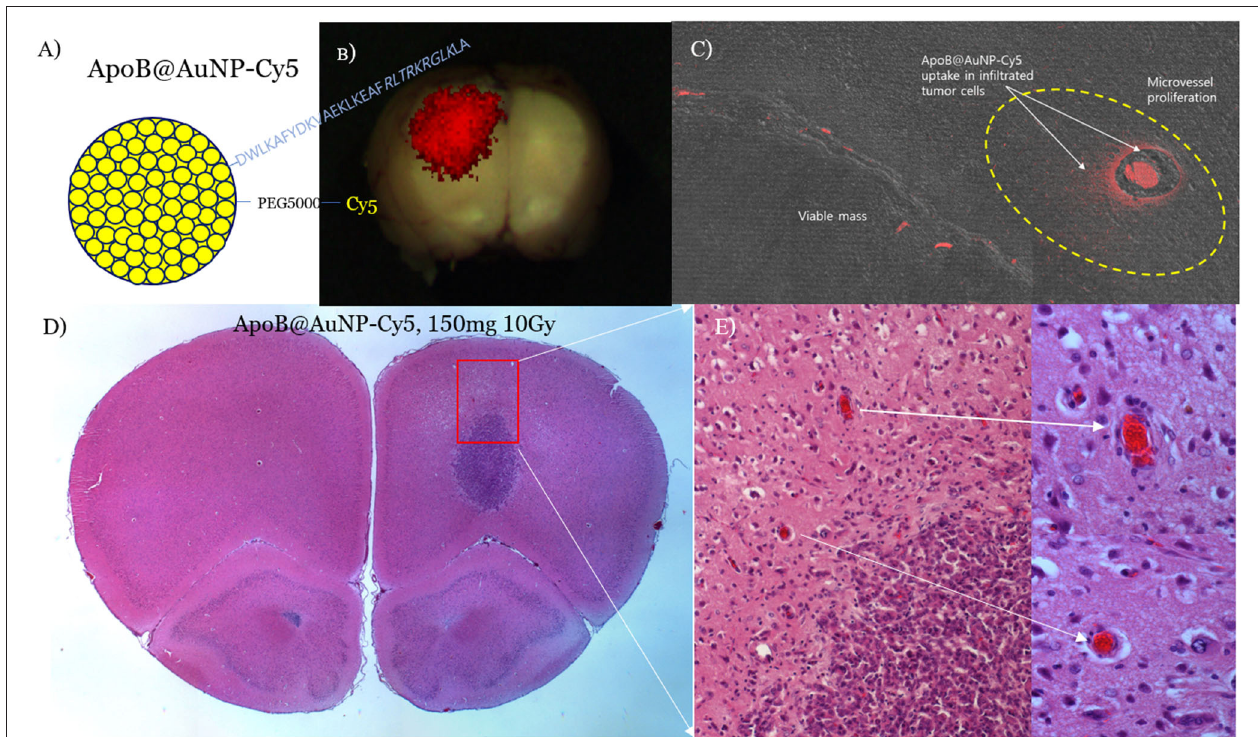
FIGURE 4 | ApoB@AuNPs-Cy5 were synthesized by conjugating a thiolated ApoB peptide and quenching-free SH-PEG5000-Cy5.5 to 10nm AuNPs (A) . Red fluorescence of LDLR-targeting ApoB@AuNPs-Cy5 showed crossing of the BBB and preferential uptake in the main mass (BBB-disrupted, 24h after iv) (B) and infiltrative microvessel proliferation (MVP) in the BBB-intact control (3 days after iv) (C) in the F98 glioma rat model. Single 10Gy proton-TIBS demonstrated a reduction in MVP and removal of infiltrated cancer cells along the microvessel (D,E)